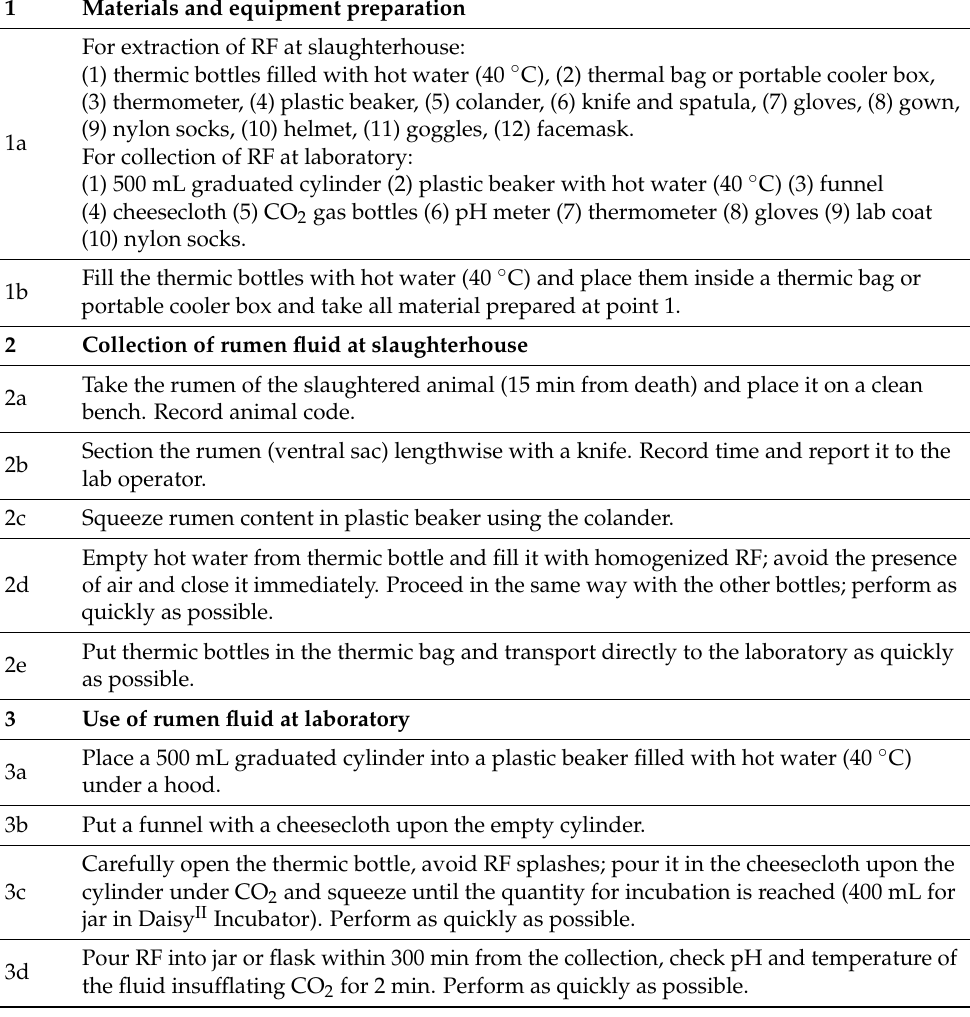
Table 4. Rumen fluid collection and use procedure for in vitro